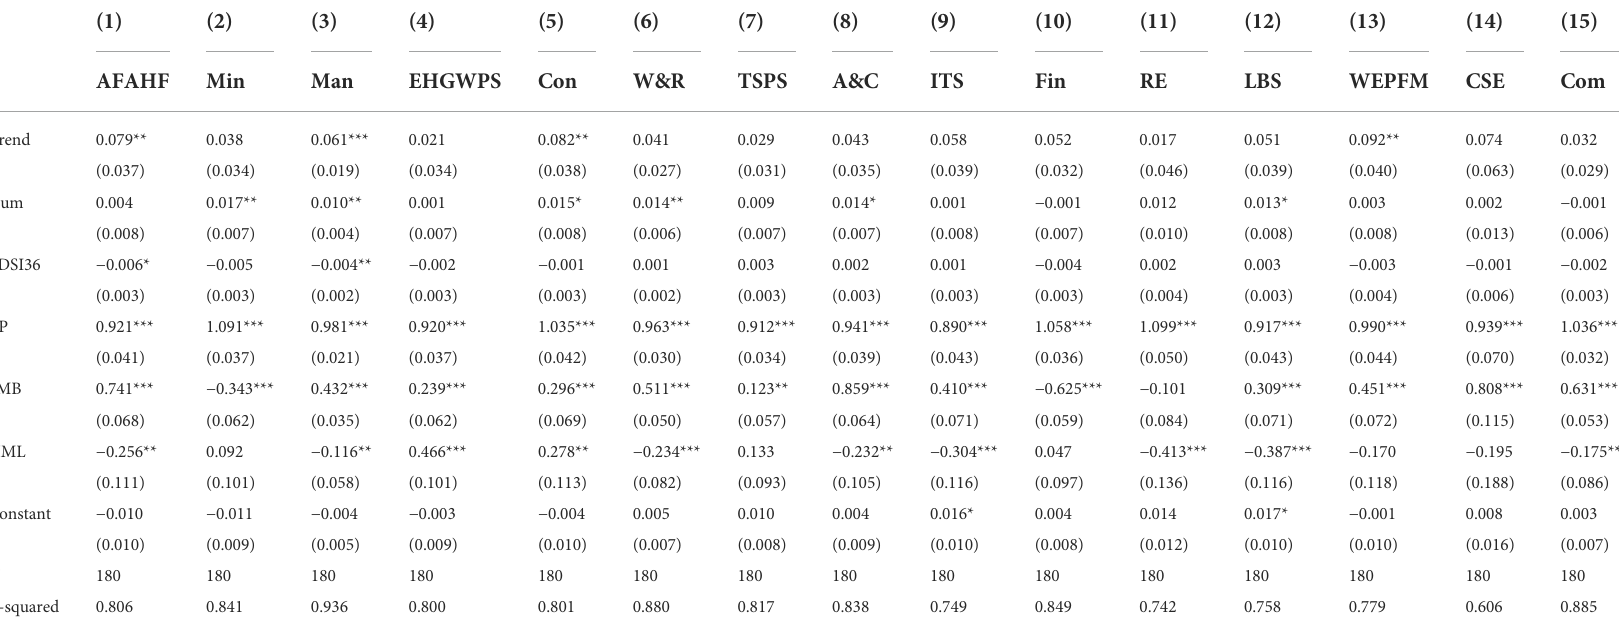
TABLE 4 The impact of different degrees of drought on industry stock